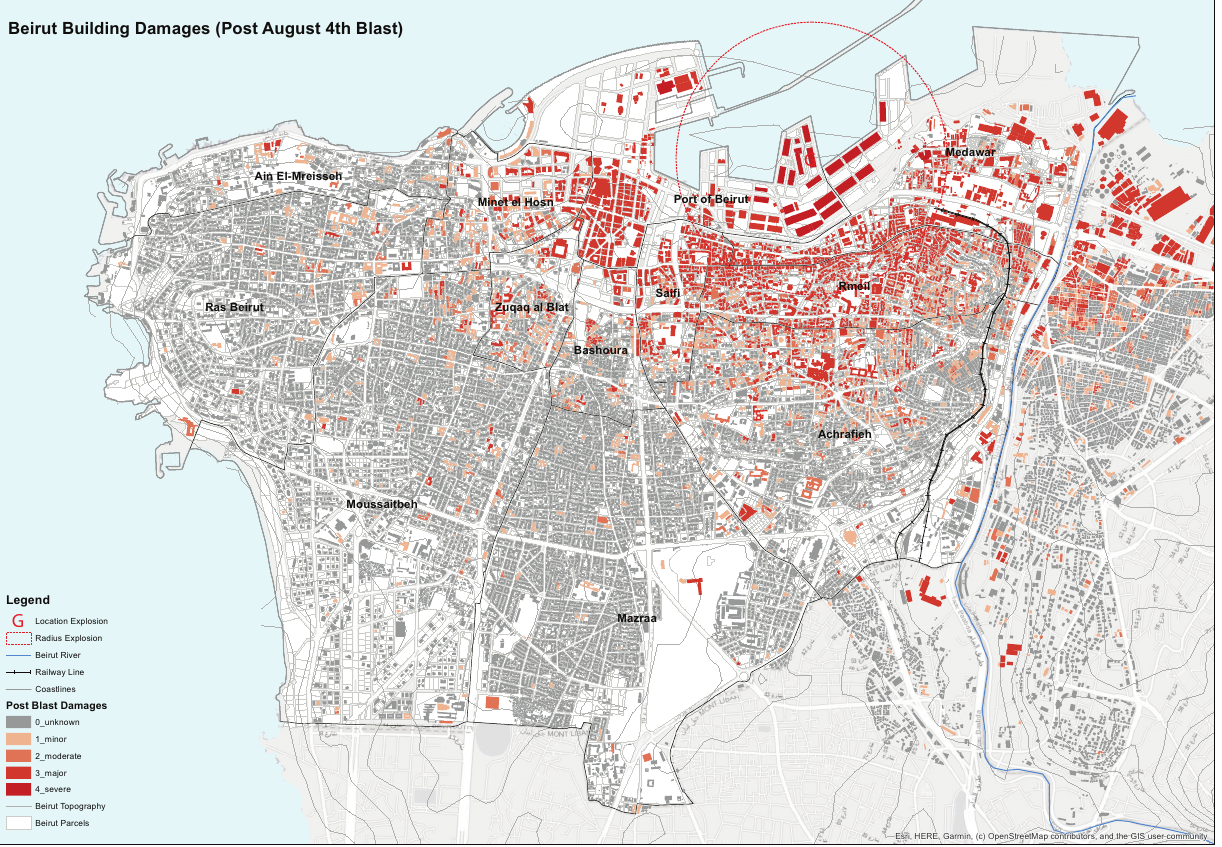
Figure 1. Post‐blast building damages in Beirut. Source: Author’s work based on the Order of Engineers and Architects